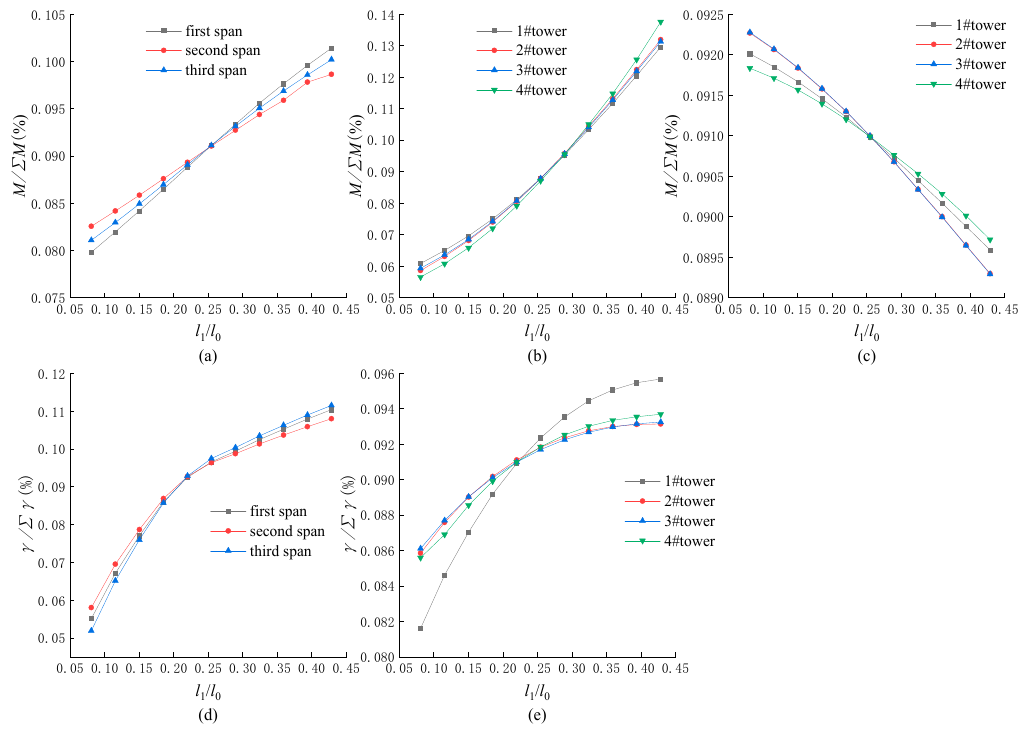
Figure 9. Comparisons of the structural effects caused by changes in length of the uncorded area in the span. ( a ) midspan bending moment; ( b ) moment at the root of the main girder tower; ( c ) moment at the root of the tower; ( d ) midspan deflection; ( e ) tower top deflection. Note: M/ ∑ M (%), γ / ∑ γ (%) have the same meaning as above.